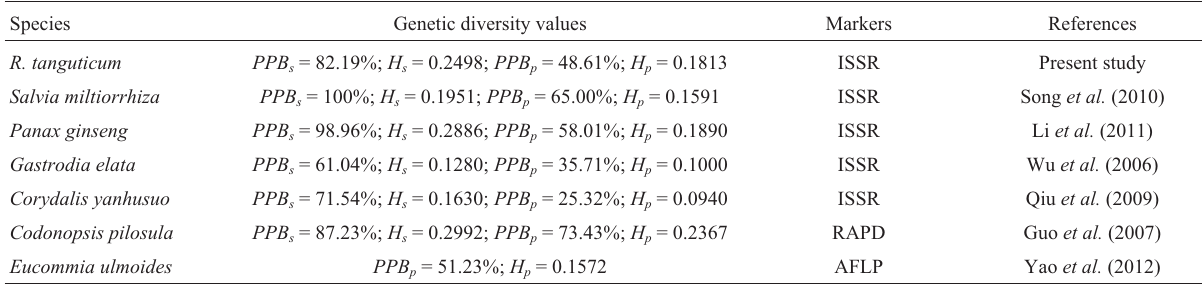
Table 6 - Comparison of genetic diversity of cultivated R. tanguticum with other important herbs in cultivated populations. Species Genetic diversity